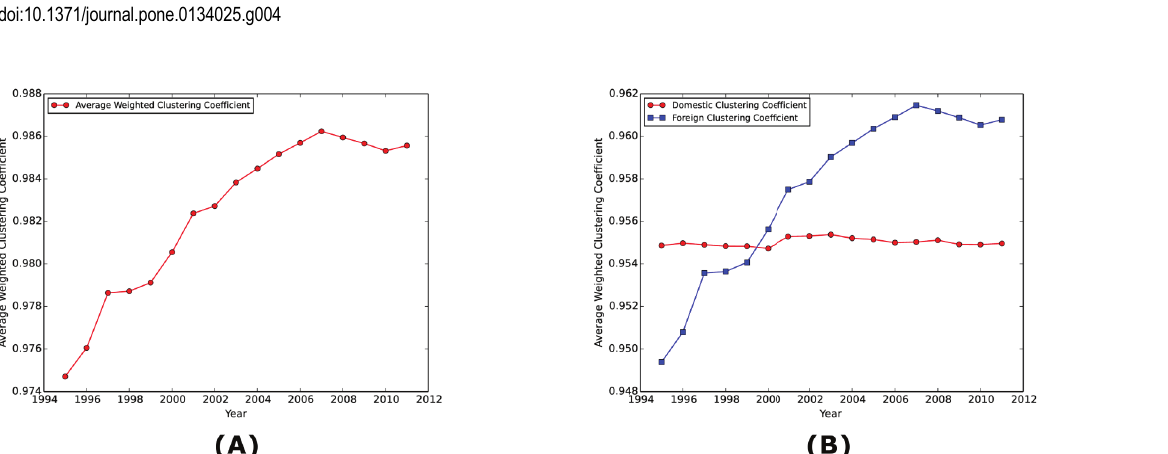
Fig 4. Foreign Share of the Intermediate Transactions. We calculate the foreign share of the transactions matrix Z over time. We calculate the percentage of inputs from foreign origins (or equivalently, the percentage of outputs to foreign destinations) of the transactions matrix Z of the 40 WIOD economies. The same hump-shaped behavior over time is observed here as in assortativity and clustering coefficient.